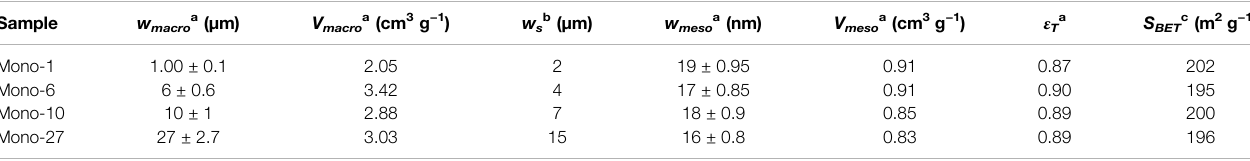
TABLE 1 | Textural properties [macropore width ( w macro ), macropore volume ( V macro ), monolith skeleton thickness ( w s ), mesopore width ( w meso ), mesopore volume ( V meso ), total porosity ( ε T ), and BET surface area ( S BET )] of the synthesized